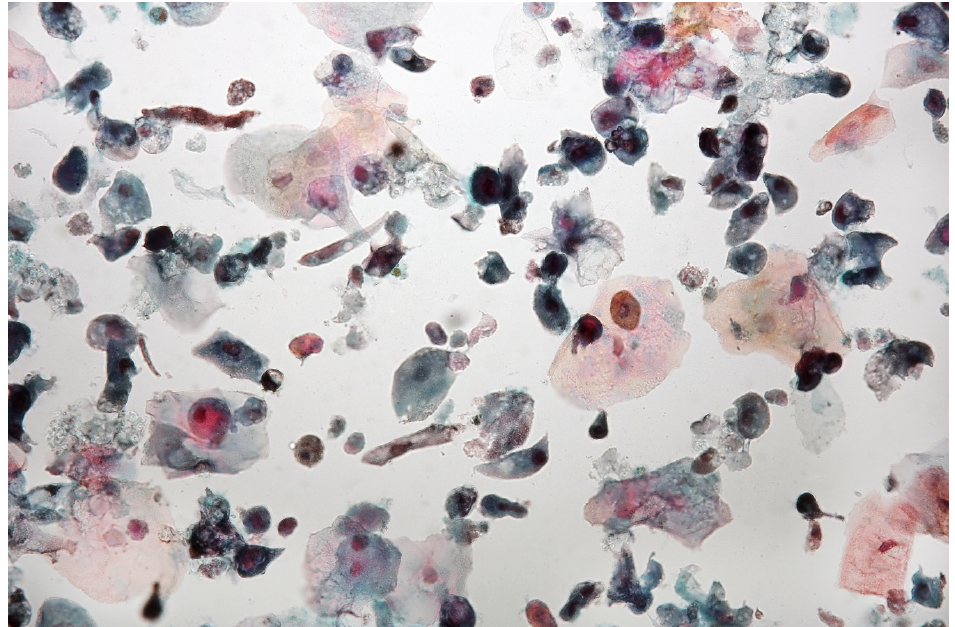
Figure 8. Urine sediment—a cytological specimen. Papanicolau staining. Atypical cells with high N/C ratios (~5% of cells with N/C ratio ≥ 0.7 and ~12% with N/C ratio ≥ 0.5 and <0.7) are visible. A significant amount of normal urothelial cells are visible. There are a few multinucleated cells, granulocytes and uric acid crystals. Significant vacuolisation of the cellular cytoplasm may indicate a strong regenerative reaction. The AUC (atypical urothelial cells) result was stated, based on The Paris System for Reporting Urinary Cytology. Table 3. Results of monitoring with the Bladder EpiCheck test. The follow-up tests began after the initial six doses of BCG treatment.